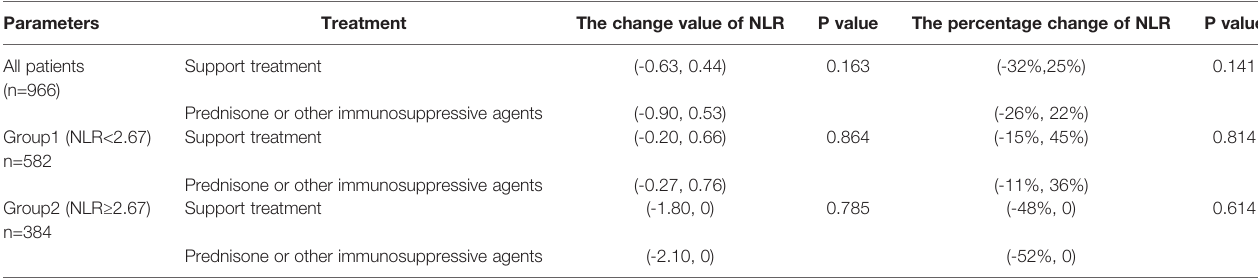
TABLE 4 | The change of NLR after treatment of 966